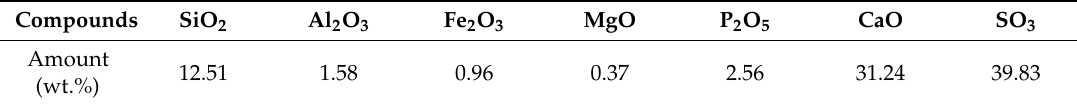
Figure 1. XRD di ff raction pattern of phosphate ore and phosphogypsum: ( a ) XRD di ff raction pattern Figure 1. XRD diffraction pattern of phosphate ore and phosphogypsum: ( a ) XRD diffraction pattern of phosphate rock; and ( b ) XRD di ff raction pattern of phosphogypsum. of phosphate rock; and ( b ) XRD diffraction pattern of phosphogypsum. Table 2. Composition of